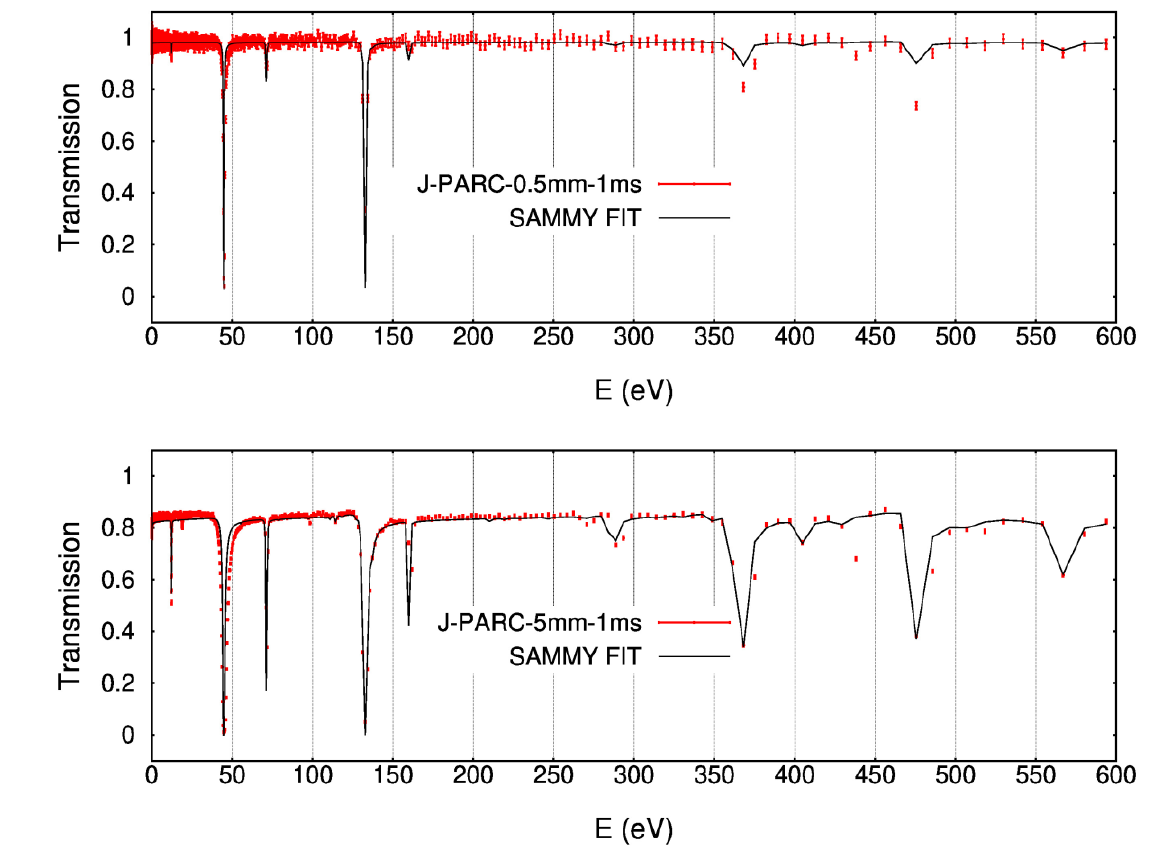
Figure 5. Fit of the J-PARC measurement values for 0.5-mm (top) thick sample and reconstruction of resonance for 5-mm (bottom) thick